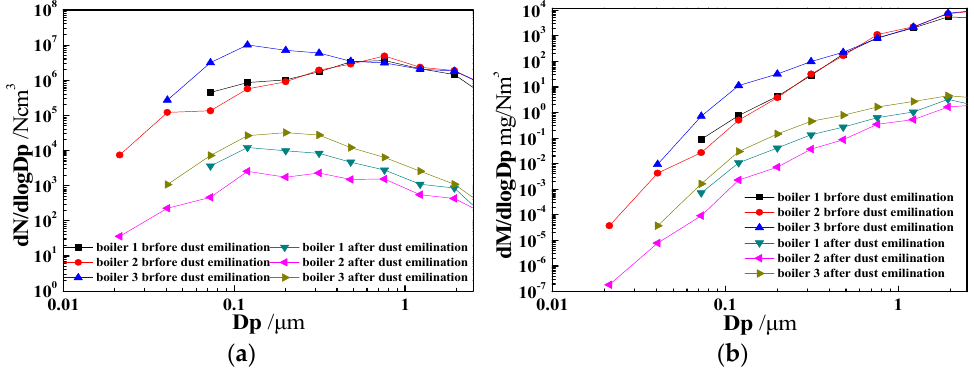
Figure 3. Concentration size distributions of fine particle at upstream and downstream of CFB boiler dust remover. ( a ) number concentration; ( b ) mass concentration.